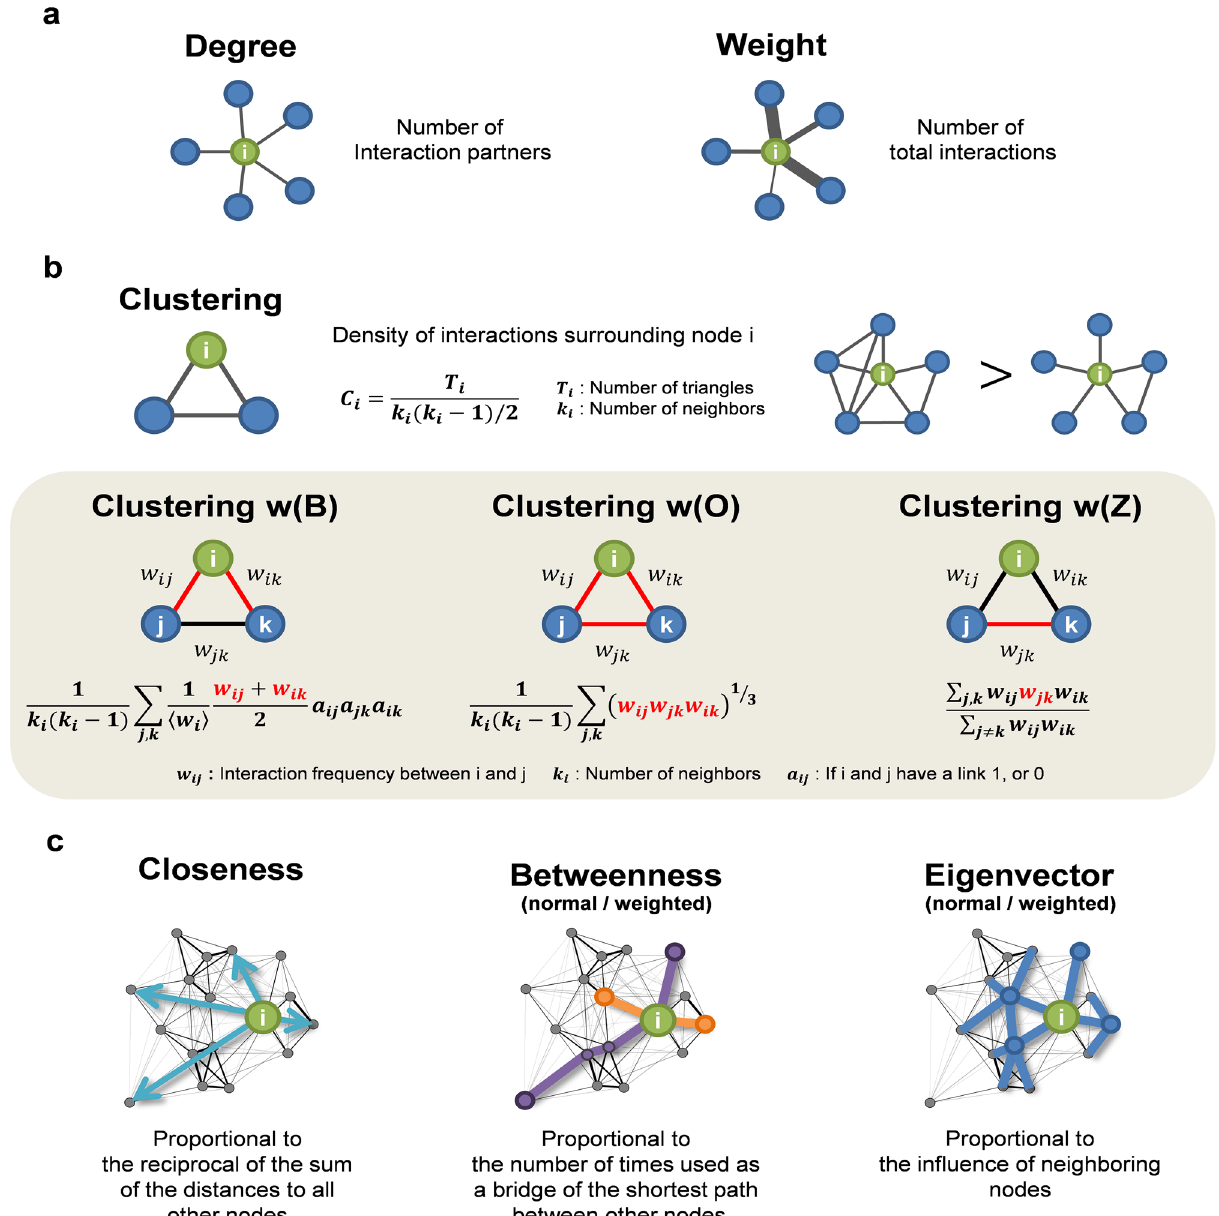
Figure 5. Social network characteristics used in analysis. ( a ) At the individual scale, the number of interaction partners ( Degree ) and the number of total interactions of individual ( Weight ) are used. ( b ), At the surrounding scale, Clustering , which quantifies the density of surrounding interactions with the number of triangular structures, and Clustering w(B) , Clustering w(O) , and Clustering w(Z) , which consider the weight of each link of a triangle, are used. ( c ) At the organizational-scale, Closeness centrality, which quantifies the proximity to other nodes, Betweenness centrality, which quantifies the role of a bridge connecting the shortest path between other nodes, and Eigenvector centrality, which quantifies the influence of neighbouring nodes, are used. For a detailed description of each metric, see “Methods”